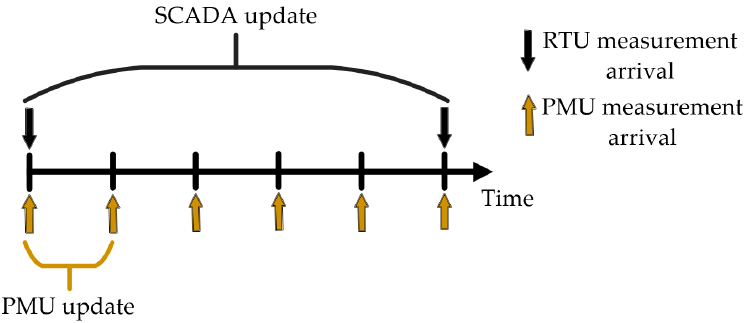
Figure 3. The dissimilarity between RTU and PMU measurement refresh rates.